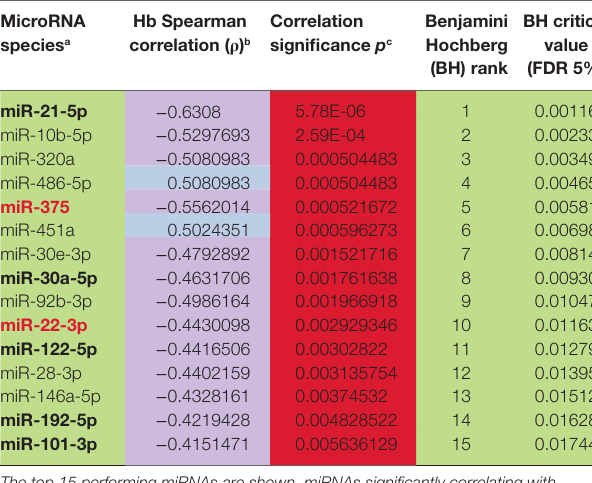
TaBle 3 | Correlations of circulating inflammatory-relevant microRNAs (CIR- miRNAs) with free hemoglobin levels in non-infective systemic inflammatory response syndrome (SIRS).